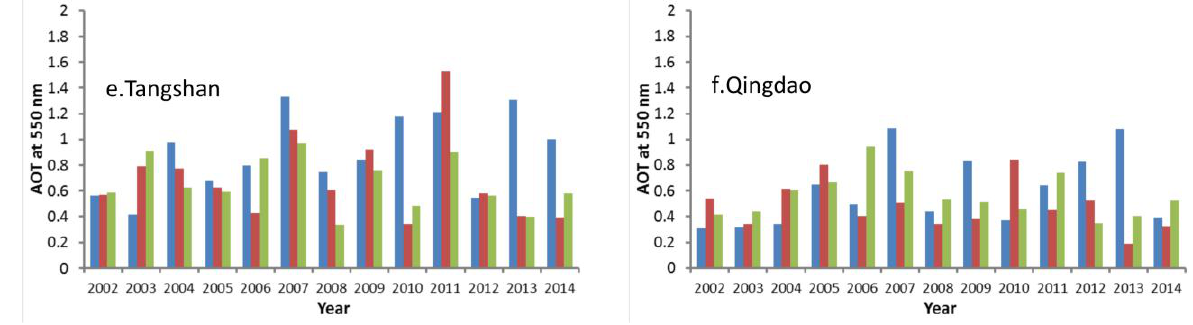
Figure 5. Mean AOT value before, during, and after APEC period from 2002 to 2014 ( a ) Beijing, ( b ) Tianjin ( c ) Jinan, ( d ) Shijiazhuang, ( e ) Tangshan, ( f ) Qingdao.